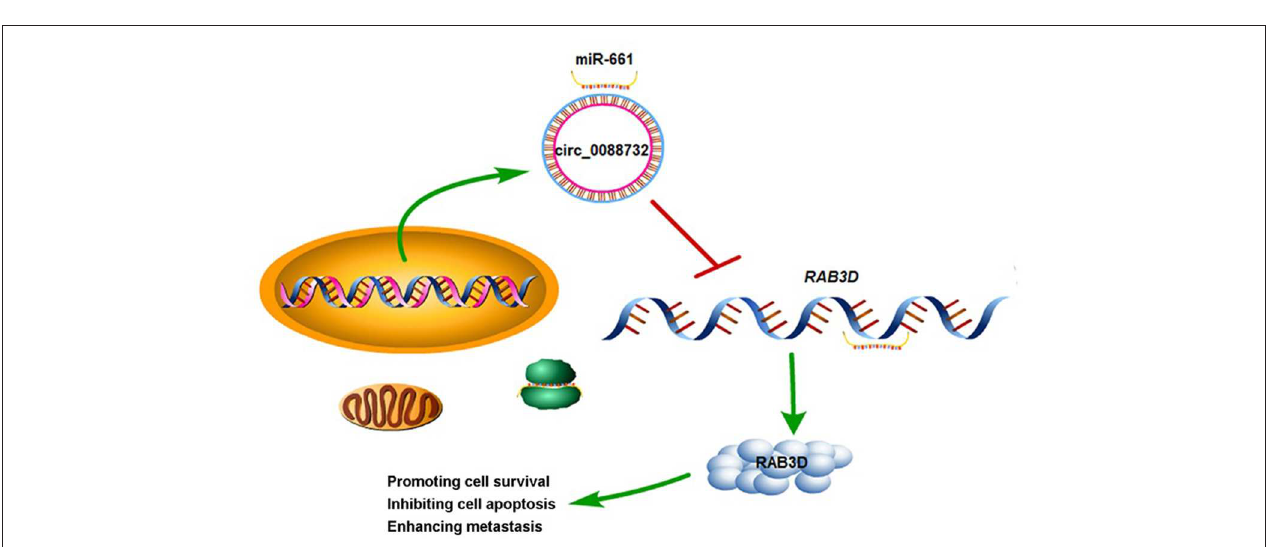
FIGURE 11 | A schematic diagram of the hsa_circ_0088732/miR-661/RAB3D axis in glioma. hsa_circ_0088732 was formed by the Lcn2 gene by cyclization, hsa_circ_0088732 negatively regulated miR-661, and RAB3D was a target gene of